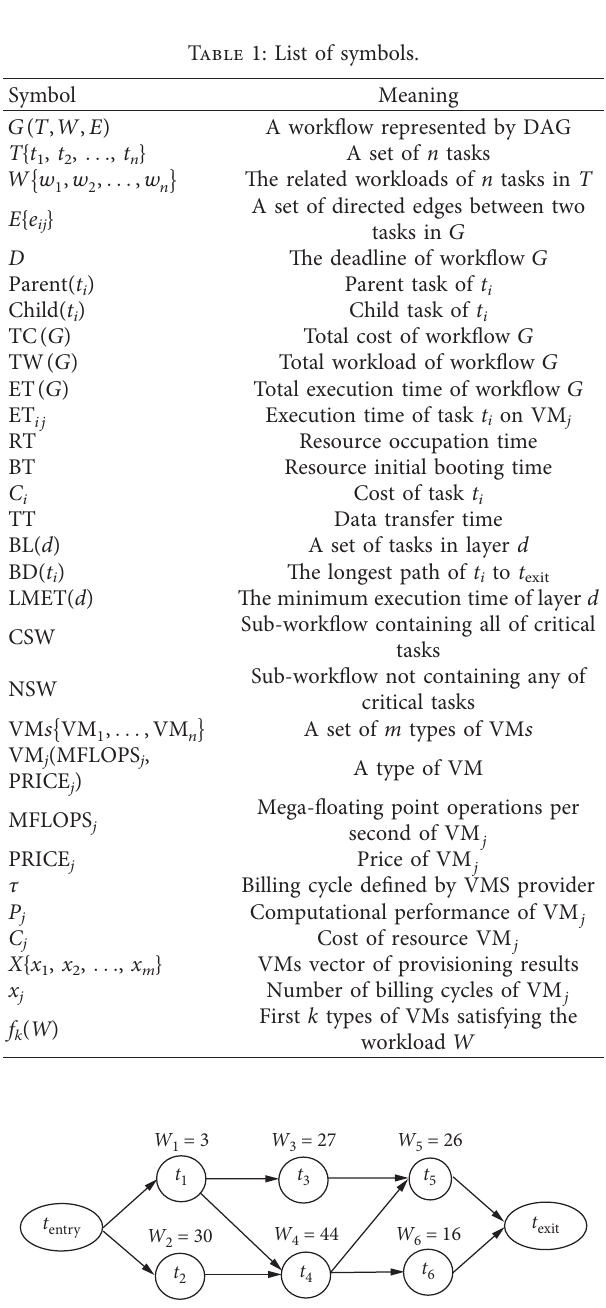
Figure 1: Sample